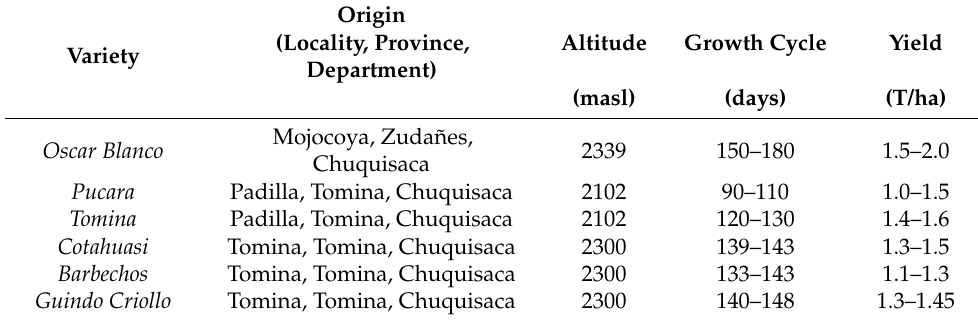
Table 1. Amaranthus caudatus varieties: origin, altitude, growth cycle and yield.